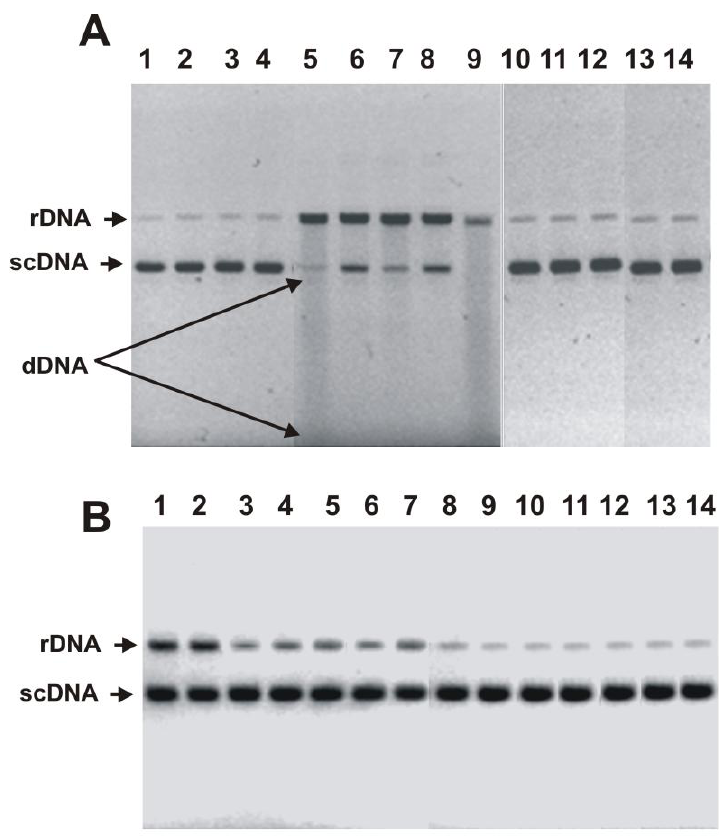
FIGURE 7 . (A) Cleavage of sc pBluescript DNA after a 30-min incubation in the presence of 0.03 mg/ml IgGs (previously dialyzed against EDTA) from five mice and 2 mM NiCl 2 (lanes 5–9) or FeCl 2 (lanes 10–14)[136]. Lanes 1 and 2 correspond to scDNA incubated with NiCl 2 or FeCl 2 , respectively, in the absence of Abs; lanes 3 and 4, incubation of scDNA with NiCl 2 and FeCl 2 in the presence of IgGs from a healthy mouse. (B) IgG-dependent cleavage of scDNA under special conditions leading to a formation of only relaxed DNA (rDNA) in the presence of IgGs from different mice and different Me 2+ ions (2 mM): 1, Mg 2+ ; 2 and 3, Mn 2+ ; 4, Cu 2+ ; 5, Ca 2+ ; 6, Co 2+ ; 7, Ni 2+ ; 8, Zn 2+ . Lanes 9–14 correspond to the incubation of scDNA without Abs in the presence of different ions (2 mM): 9, Mg 2+ ; 10, Mn 2+ ; 11, Cu 2+ ; 12, Ca 2+ ; 13, Co 2+ ; 14, Ni 2+ ). In order to limit scDNA cleavage only to the plasmid relaxation, the time of incubation was varied from 8 to 30 min, and the Abs were used in the concentrations 2 × 10 –5 to 1 × 10 –3